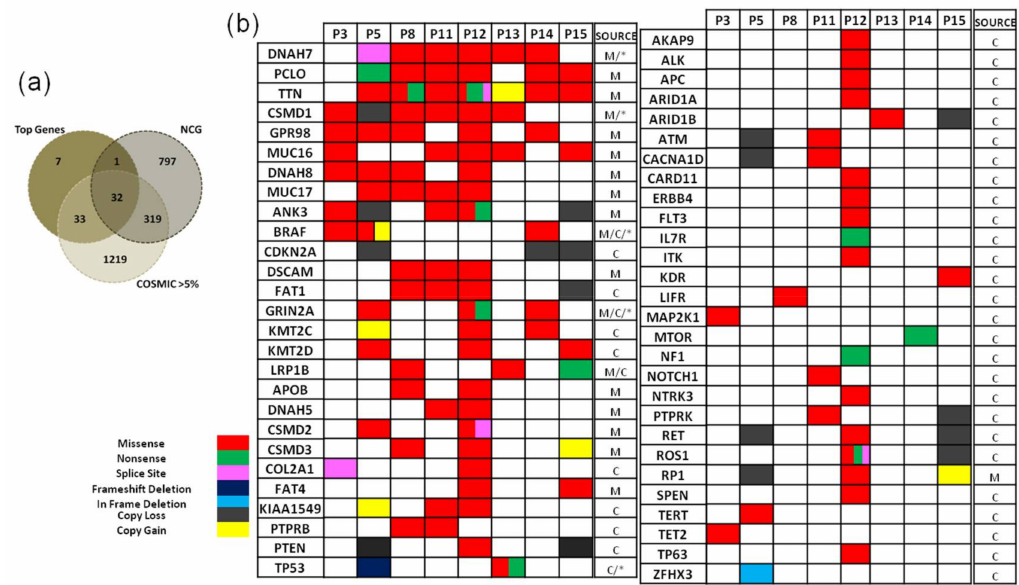
Figure 2. ( a ) Common genes between the 73-genes list, the 1571 Network of Cancer Genes (NCG) genes and the >5% mutated genes in melanoma from COSMIC; ( b ) Characterisation of genes carrying non-synonymous mutations based on COSMIC data. M-melanoma-associated genes (>20% mutated in COSMIC) and C-cancer-census genes (>5% in melanoma samples). * Denotes genes highlighted by MutSigCV (version